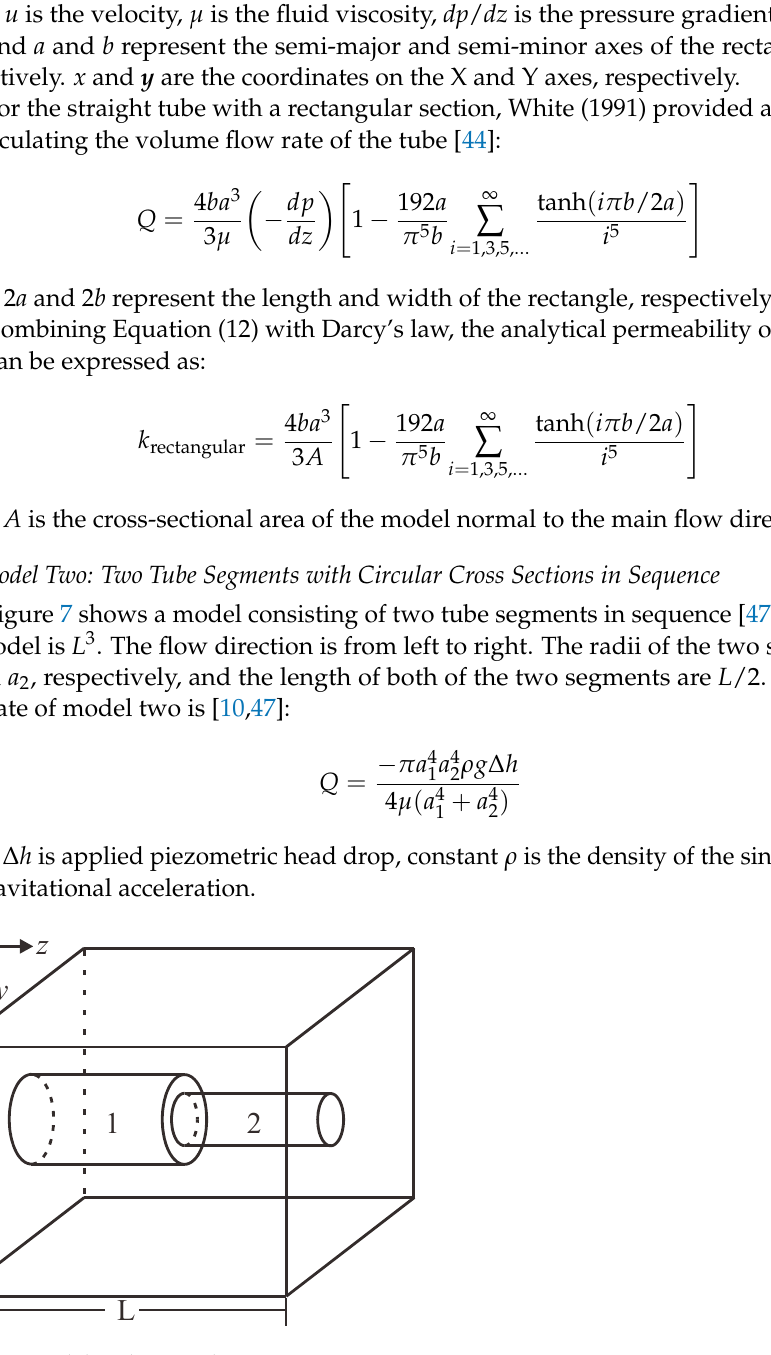
Figure 7. Model with two tube segments in sequence.